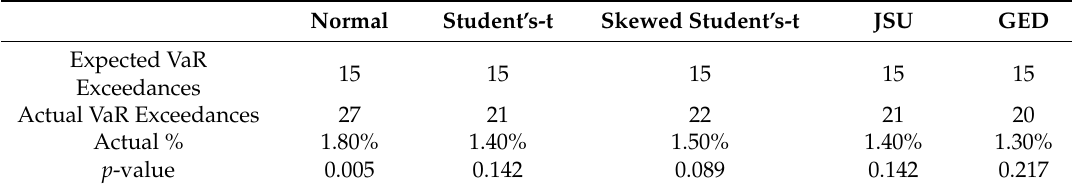
Table 5. Intraday VaR forecast: Kupiec’s test.